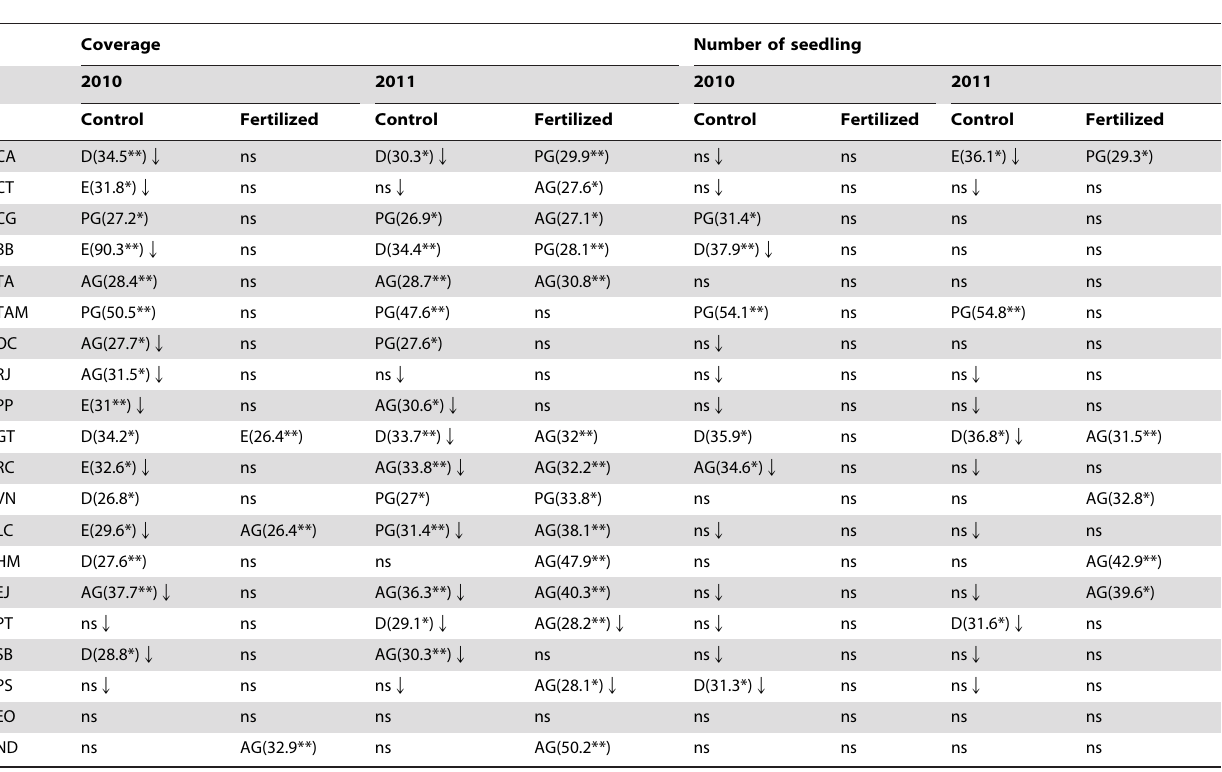
Significant relationships between the coverage and seedling number of each invader and certain dominant functional group treatment are shown for having the highest coverage and seedling number in the treatment. Numbers in parentheses are the indicator values ( IV ). Significance values are calculated based on 1000 randomizations in a Monte Carlo simulation, with *P , 0.05, **P , 0.01 and ns not significant (P . 0.05). Species abbreviations are as given in Table 2. Arrows ( Q ) indicate that the coverage and seedling number of invaders had lower values in the pots dominated by the same than by another functional group, which indicates limiting